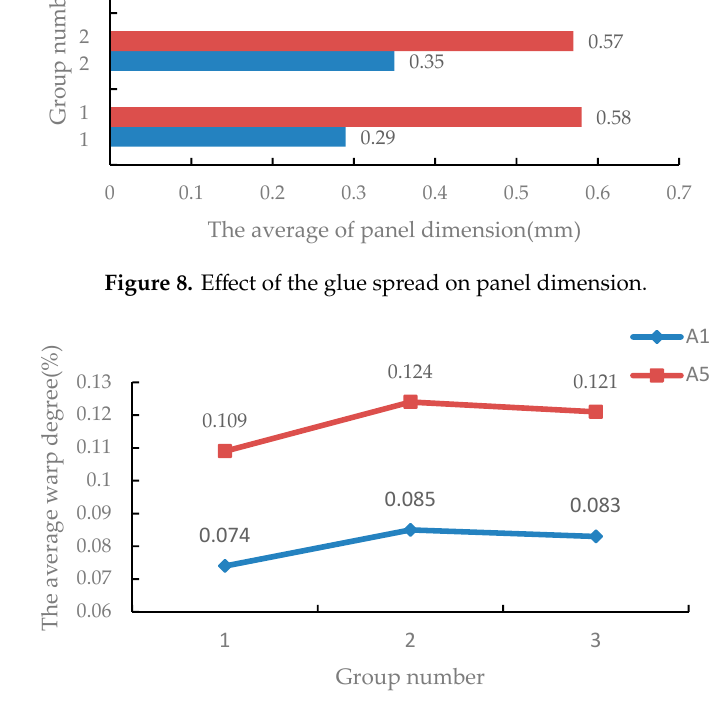
Figure 9. Effect of the glue spread on warp degree.